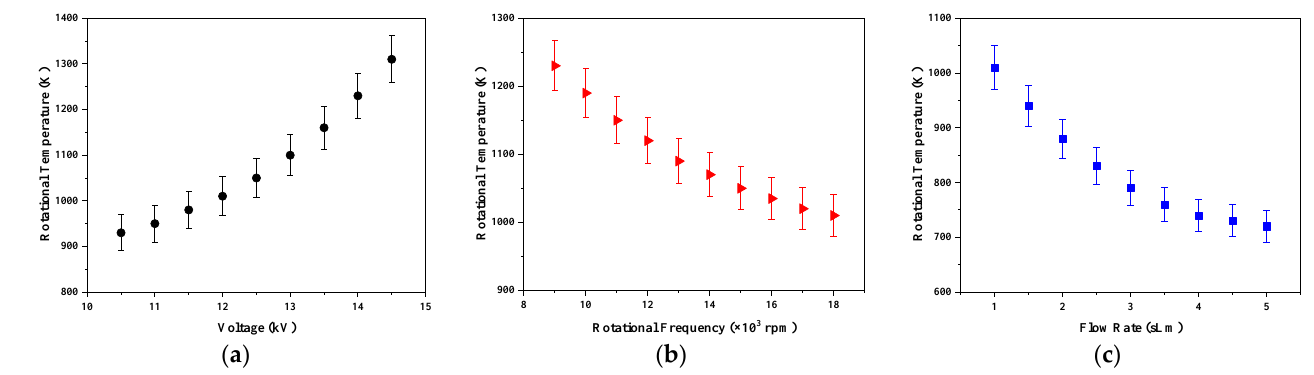
Figure 10. Fitting of the simulated spectrum to experimental measures for determination of the ro- tational temperature using a C 2 band for C 4 H 10 /C 3 H 8 gas mixture at 14 kV 3 3 applied voltage, 18,000 rpm rotation frequency, and 1 sLm gas flow rate. ( 𝐼𝐼 Π 𝑔𝑔 , 𝑣𝑣 = 1 → 𝑎𝑎 Π 𝑢𝑢 , 𝑣𝑣 = 1) The variations of the rotational temperature as a function of the applied voltage, ro-